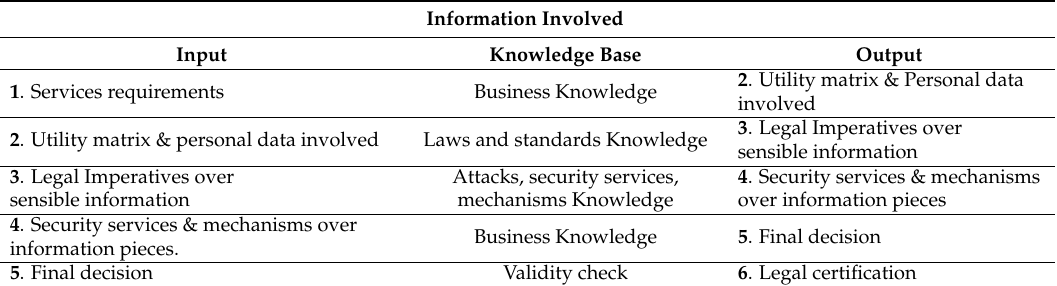
Table 2. Processing